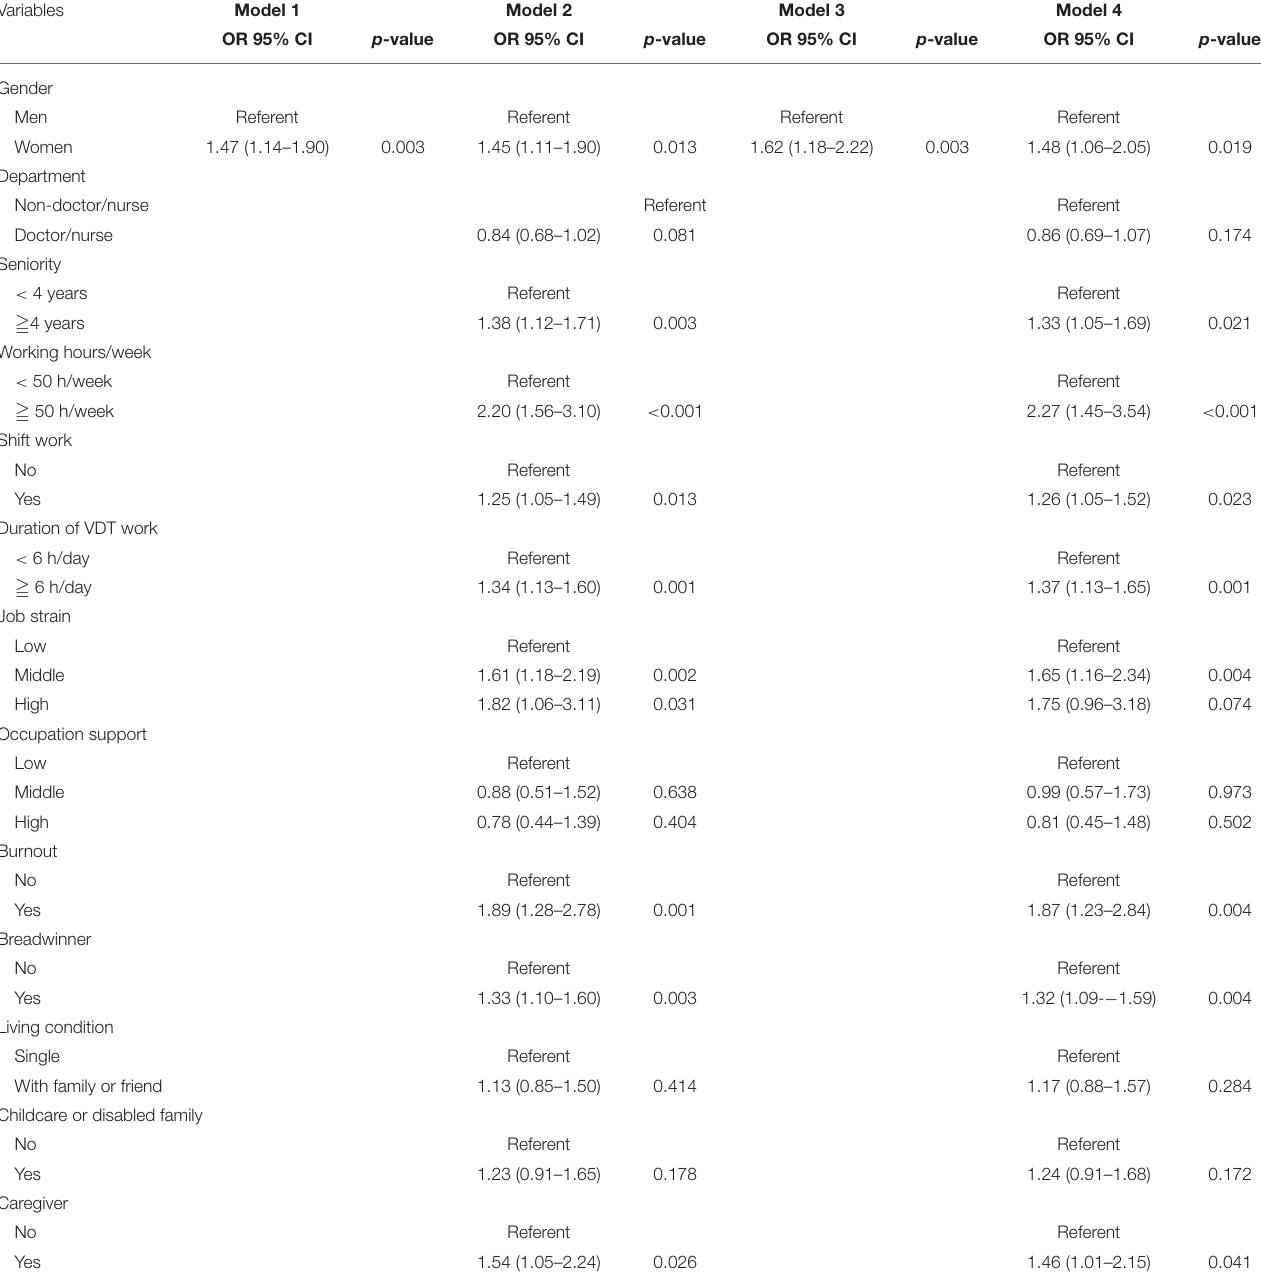
TABLE 3 | Gender differences in insomnia before and after adjustment work and family